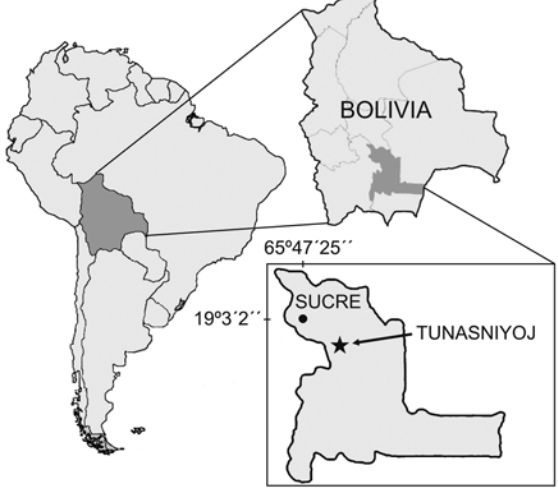
Fig. 1 – Map location of the dinosaur track locality Tunasniyoj, Chu- quisaca Department,